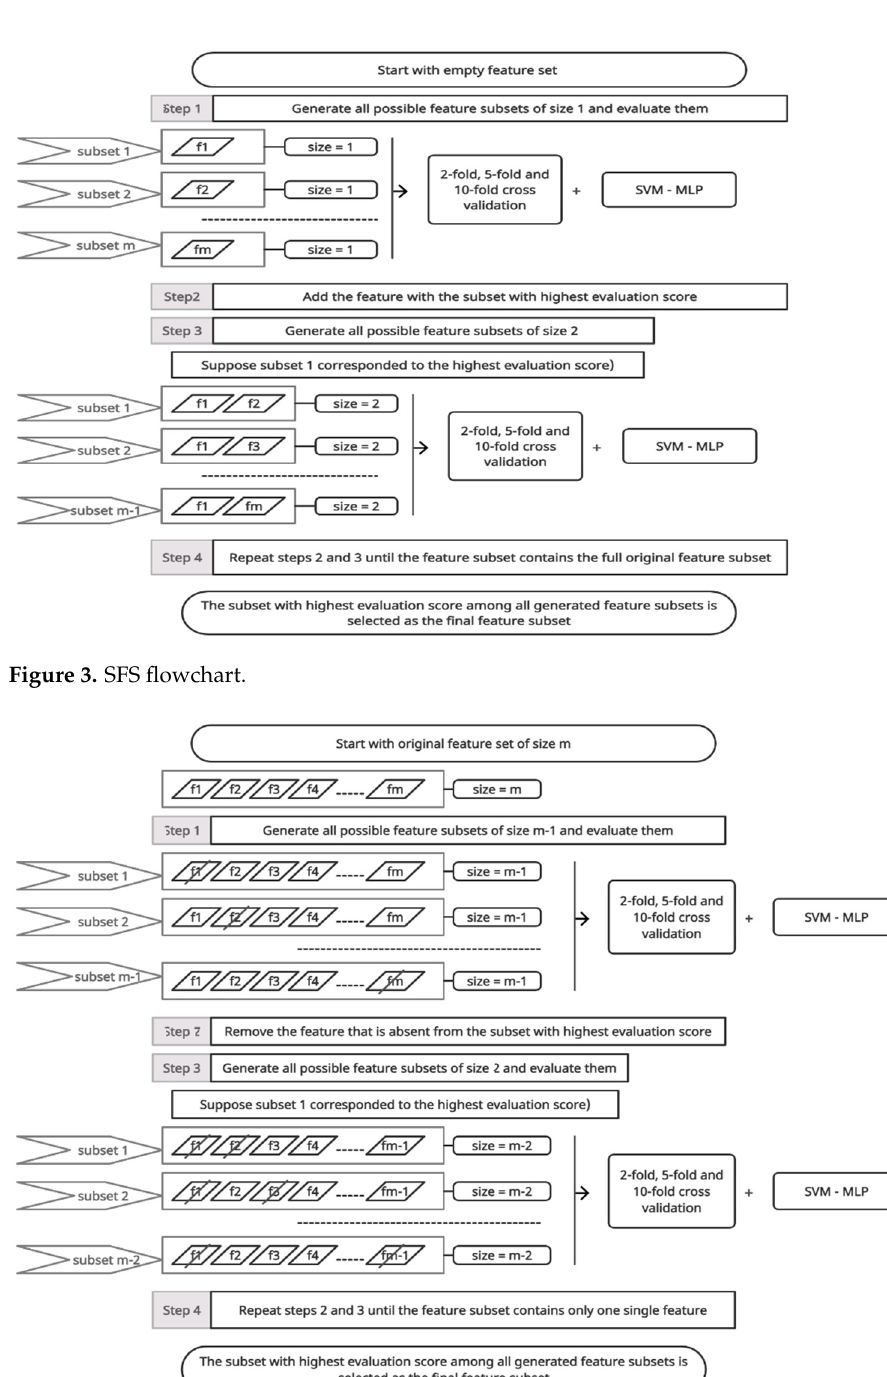
Figure 4. SBS flowchart.